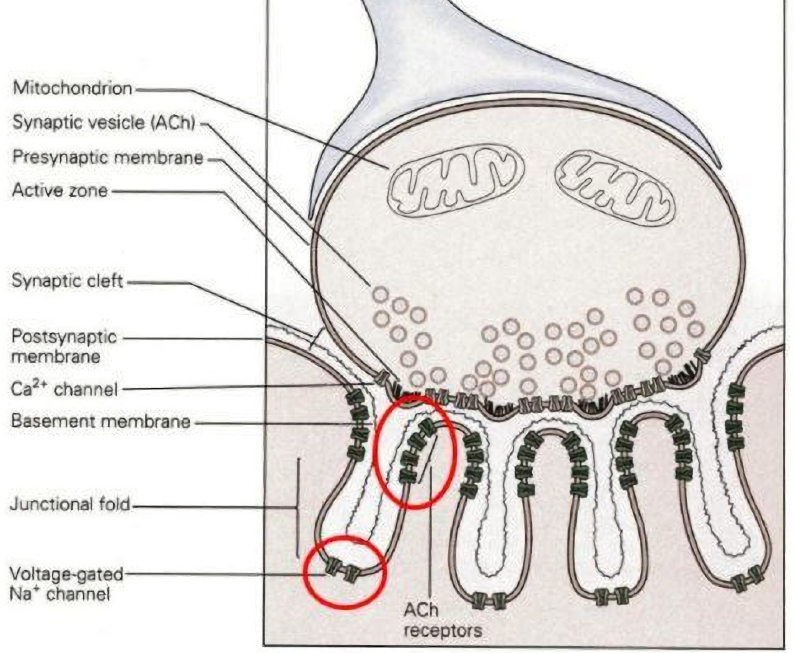
Figure 2. Illustration of the pre- and postsynaptic features of the NMJ; red circles indicate the presence of ligand-gated acetylcholine receptors at the crests of postsynaptic junctional folds, and voltage-gated sodium channels in the depths of those folds.